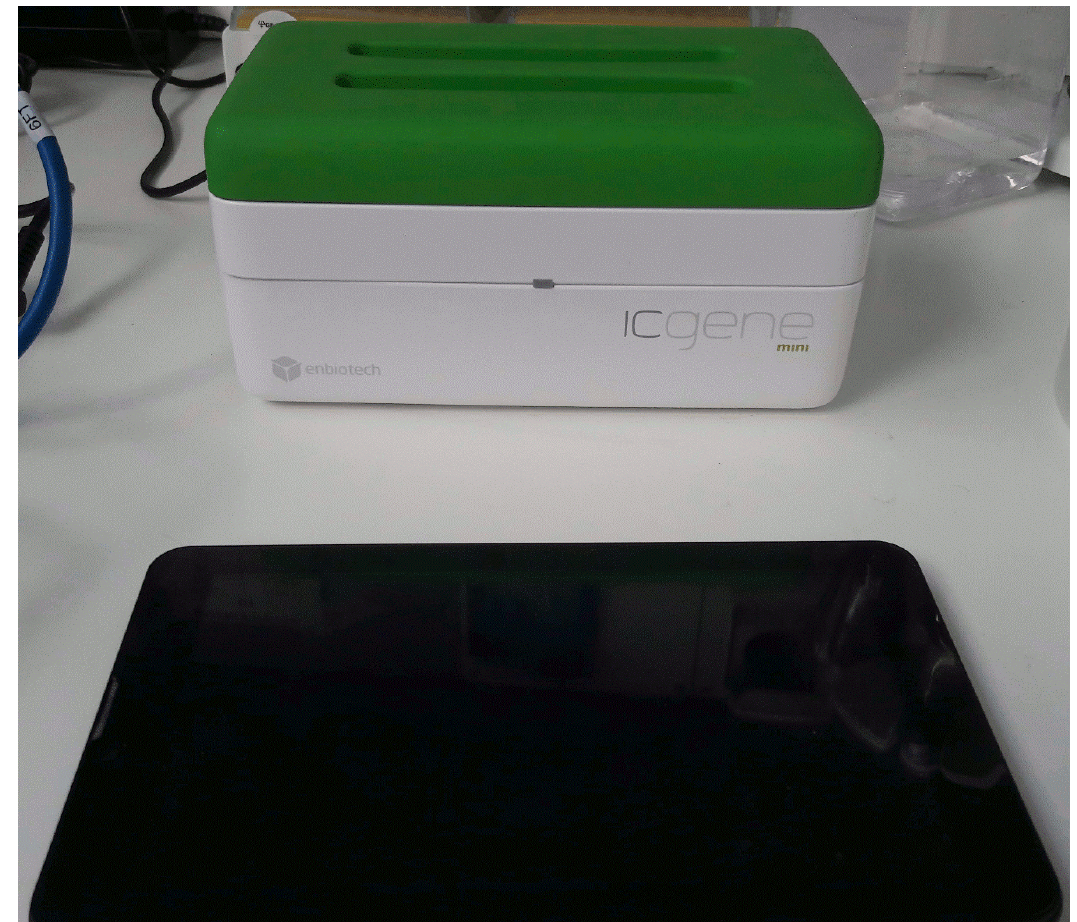
Figure 1. ICGENE mini portable instrument.